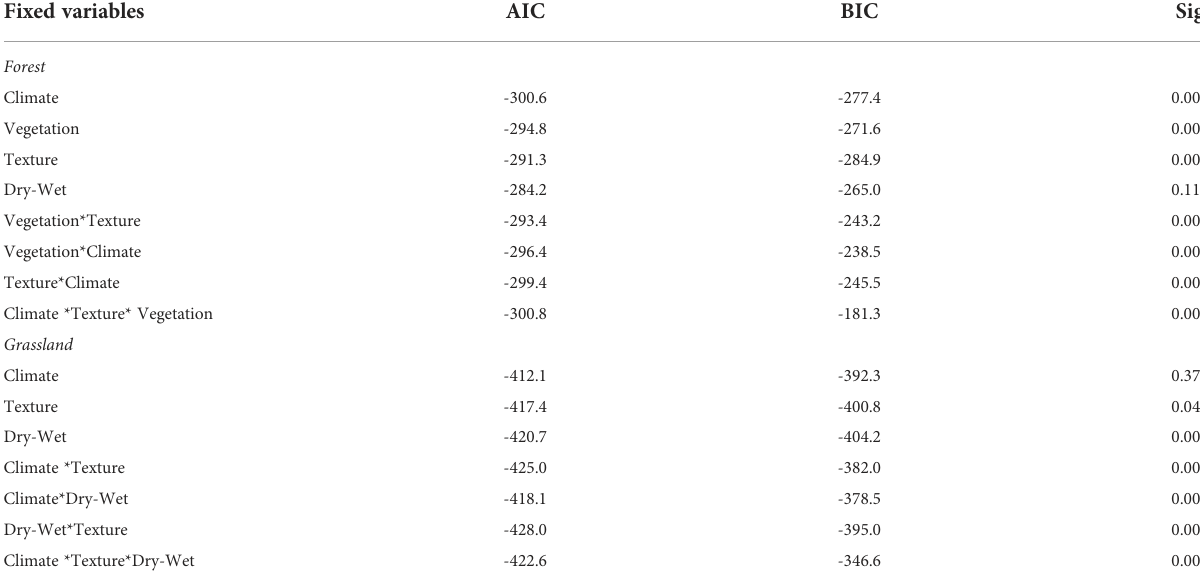
TABLE 4 AIC and BIC of mixed linear models with different category